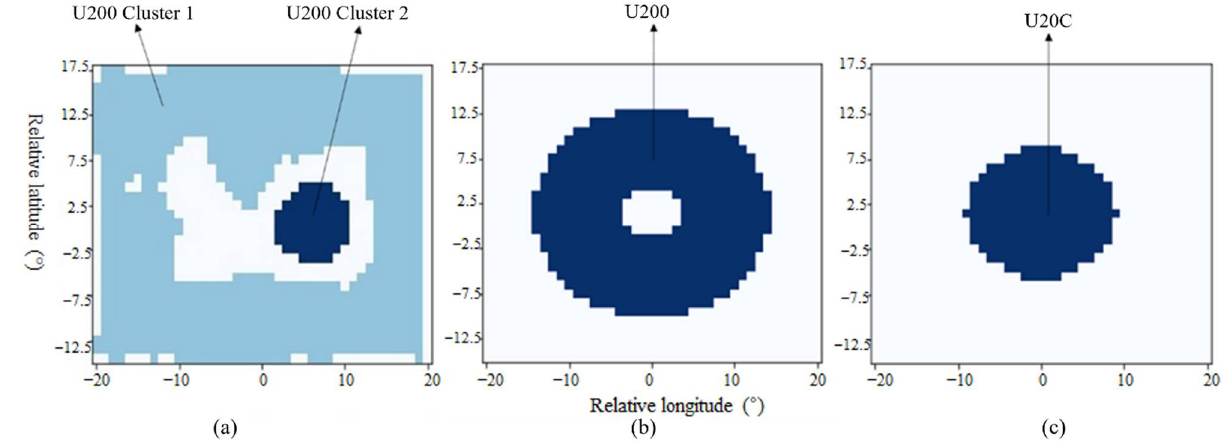
Figure 4. ( a ) Two SNN clusters of 200 hPa zonal wind that are significantly different in RI and non-RI groups; ( b ) U200 in SHIPS database; and ( c ) U20C in SHIPS database.